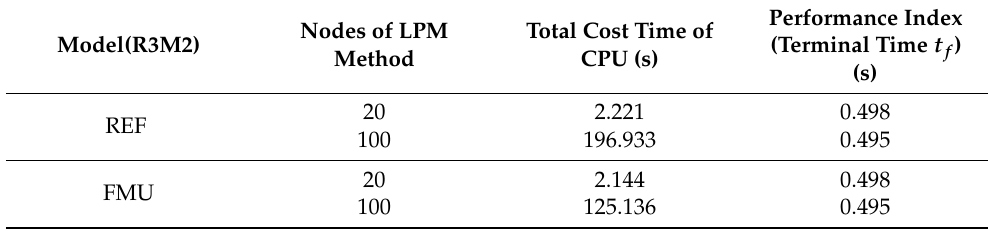
Table 1. Comparison of results of the improved method with FMU and the reference research.